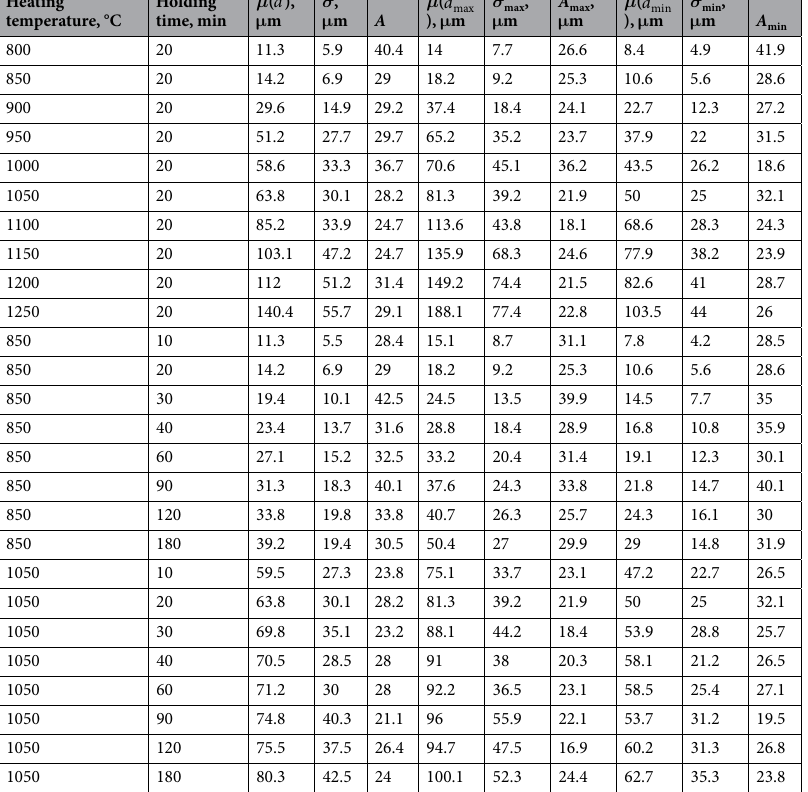
Table 2. The effects of the heating conditions on the distributions of d s , d max and d min